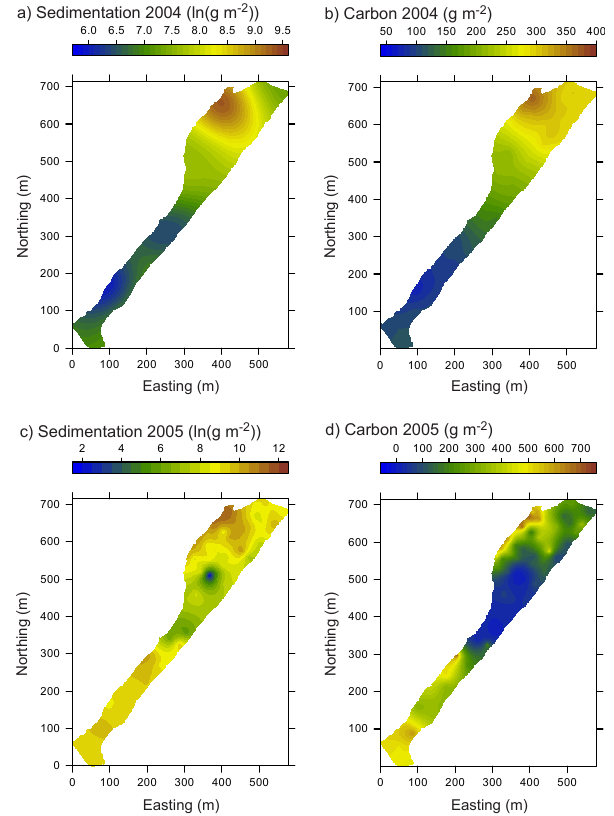
Fig. 4. Interpolation maps of sedimentation, (a and c) and sedi- ment carbon (b and d) in 2004 and 2005, respectively. Maps are displayed using different scales in 2004 and 2005 to most clearly display gradients of C and sediment deposition across the wetland during each